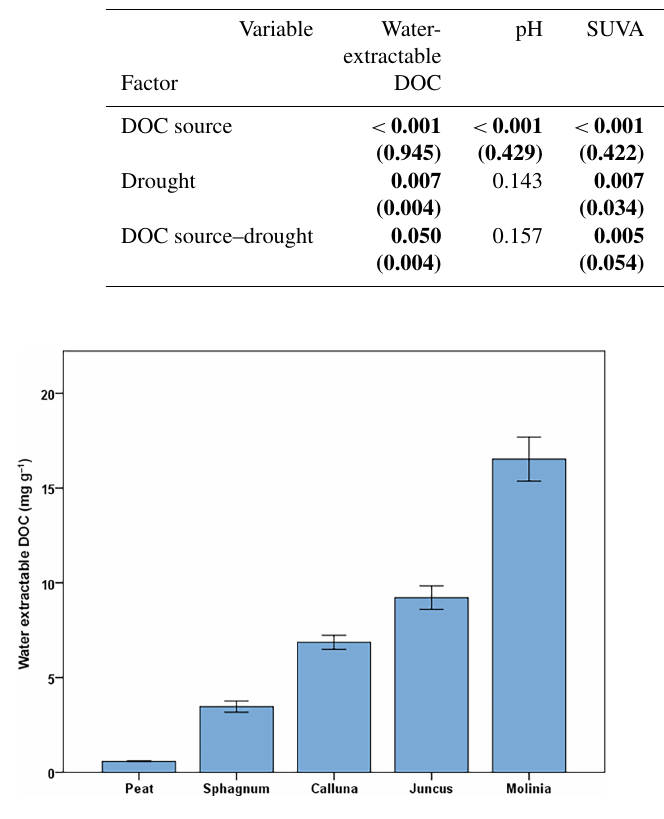
Figure 2. DOC extracted from peat on rewetting following different severities of drought ( n = 5 per treatment). Letters indicate statisti- cally similar groups from the Tukey test. Error bars at 1 standard